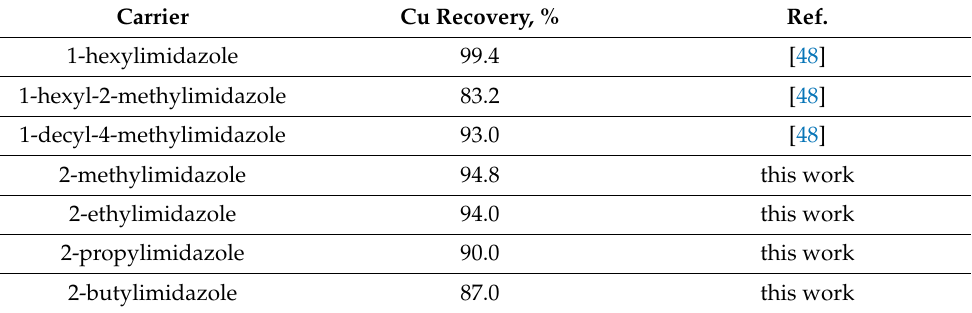
Table 7. The values of Cu(II) recovery after a 24 h transport across PIMs doped with alkylimidazoles. Carrier Cu Recovery, %